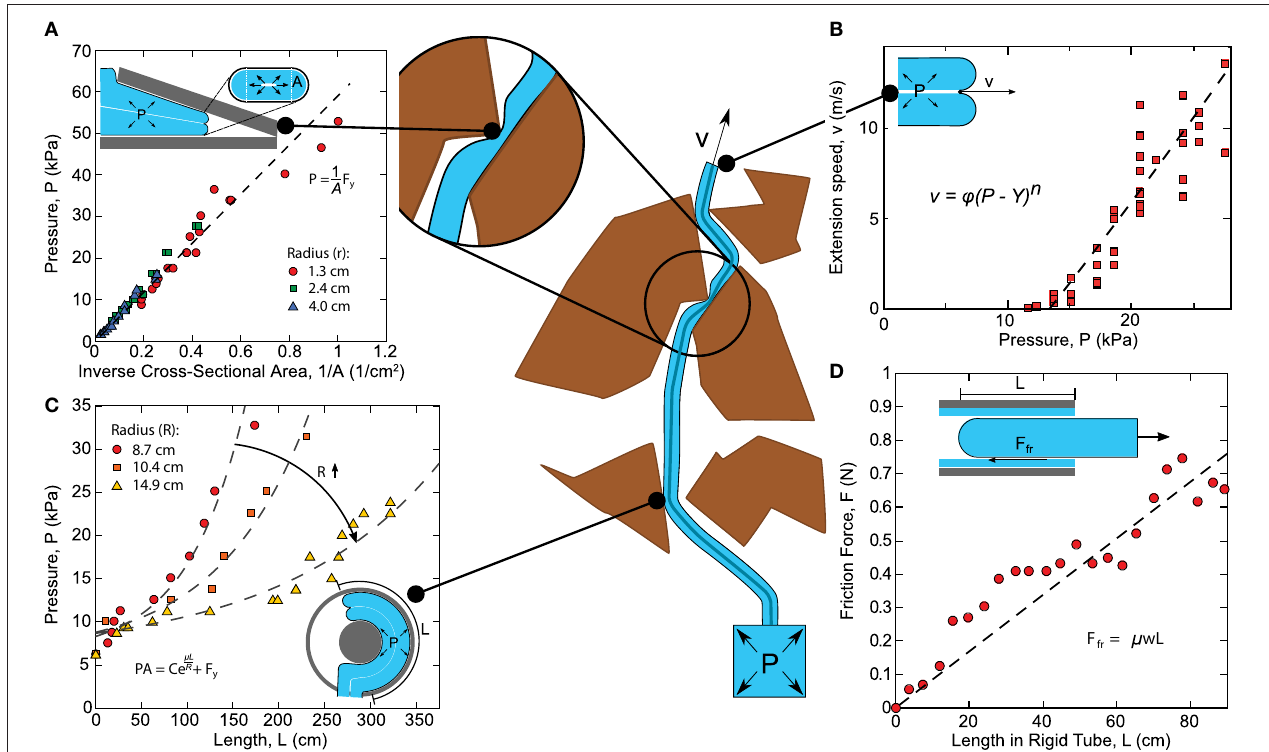
FIGURE 6 | Quasi-static modeling of everting vine robot growth. Model relates the driving force (internal pressure times tip cross-sectional area) to the losses due to the robot state, including (A) static yield force (i.e., driving force required to begin growth), (B) viscoplastic loss due to everting material, (C) exponential friction for moving tail material around curves in path, and (D) linear friction as a function of length/weight of tail material being transported. Modified from Blumenschein et al. (2017). Reprinted with permission from Springer Nature.